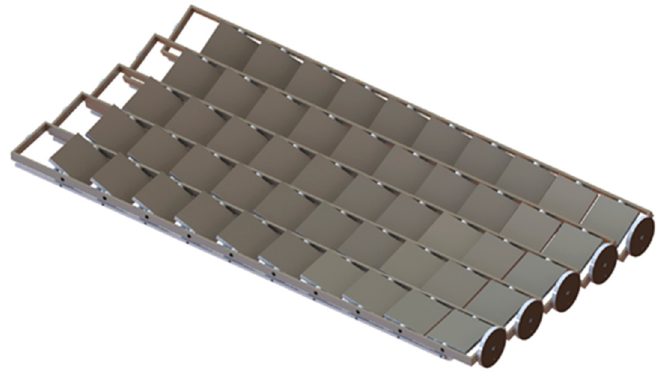
Figure 1. Concept of the BAF concentrator.